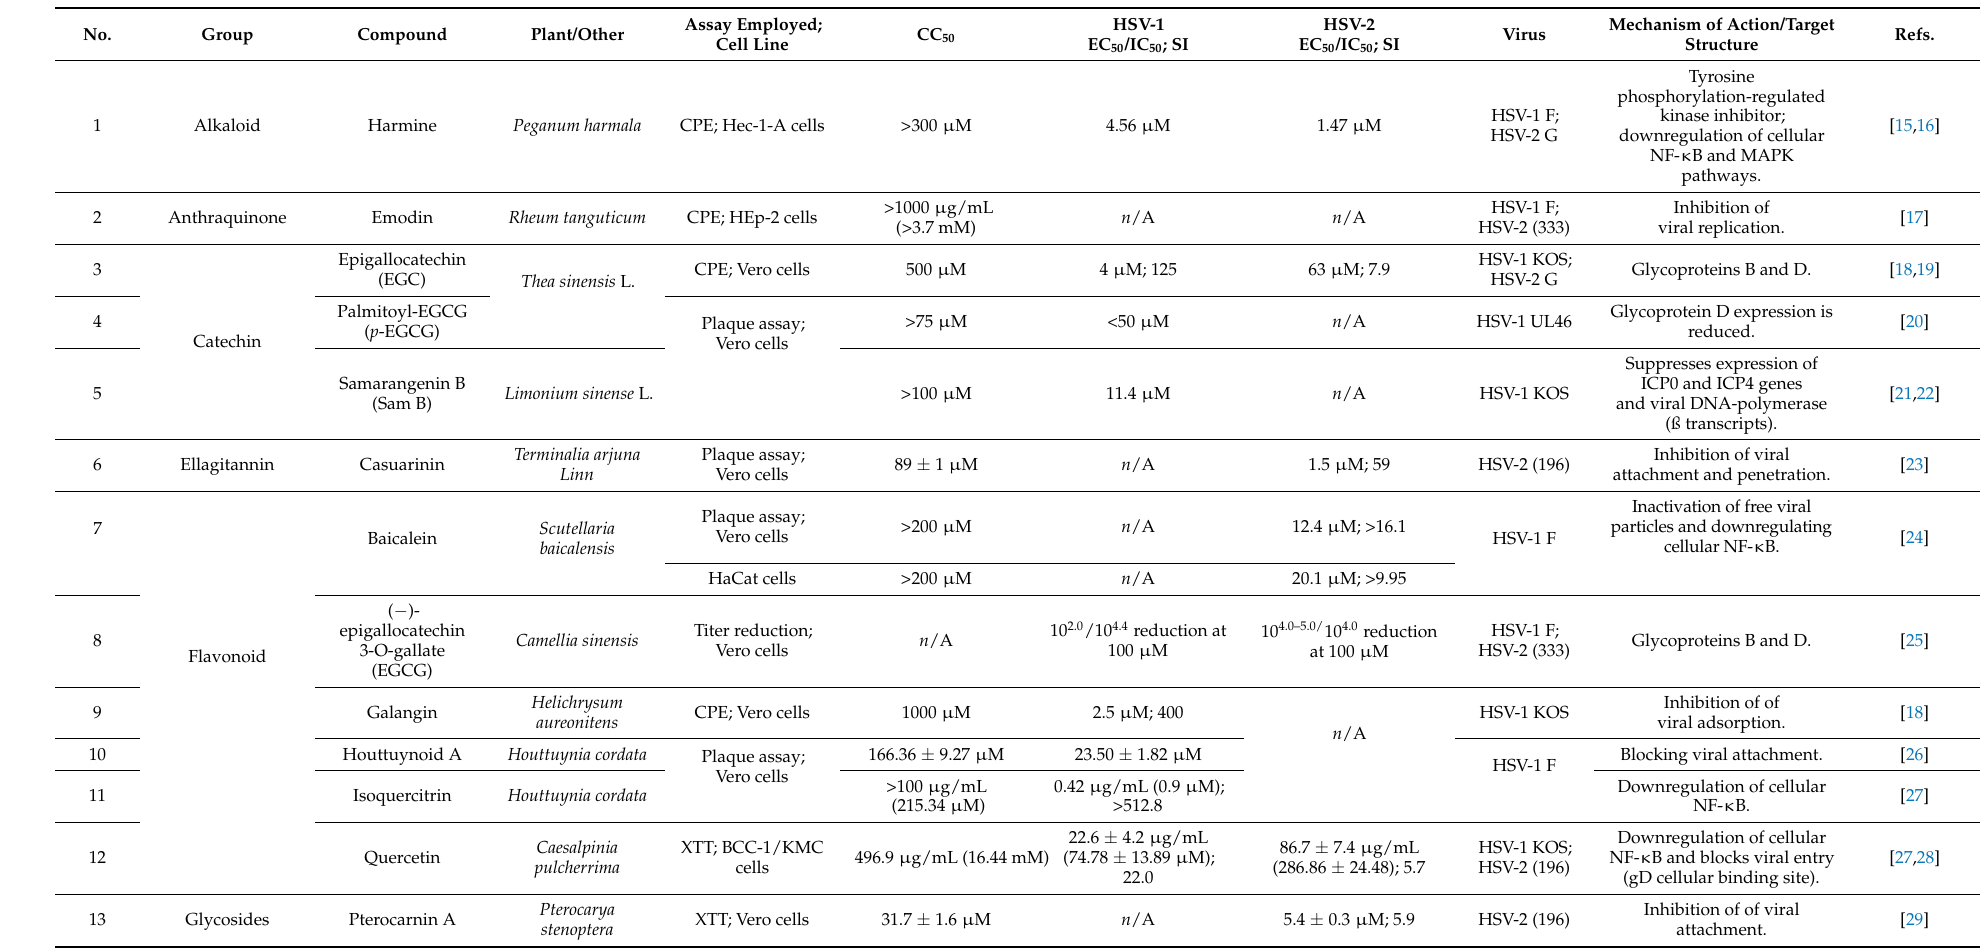
Table 1. Chemical compounds and their anti-HSV activity. CC 50 = 50% cytotoxic concentration, EC 50 = 50% effective concentration, IC 50 = 50% inhibitory concentration, SI = selectivity index, HSV = herpes simplex virus, CPE = cytopathogenic effect, XTT = 2,3-bis[2-methoxy-4-nitro-5-sulphophenyl]-5-[(phenylamino)carbonyl-2H-tetrazolium hydroxide], ELISA = enzyme-linked immunosorbent assay, MAPK = mitogen-activated protein kinase, CCECs = cerebral capillary vessel endothelial cells, PMNs = polymorphonuclear leukocytes, TK = thymidine kinase. No. Virus Mechanism of Action/Target Structure